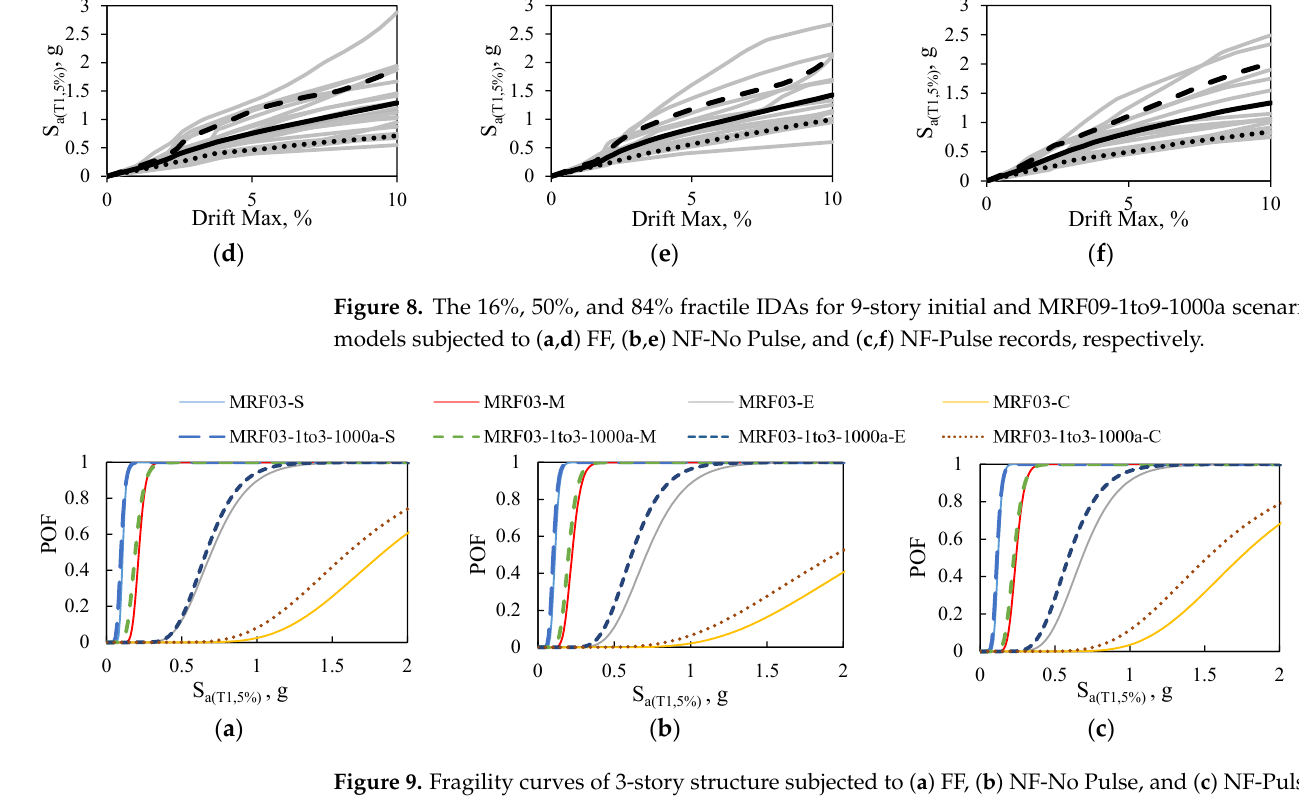
Figure 9. Fragility curves of 3-story structure subjected to ( a ) FF, ( b ) NF-No Pulse, and ( c ) NF-Pulse records, respectively.